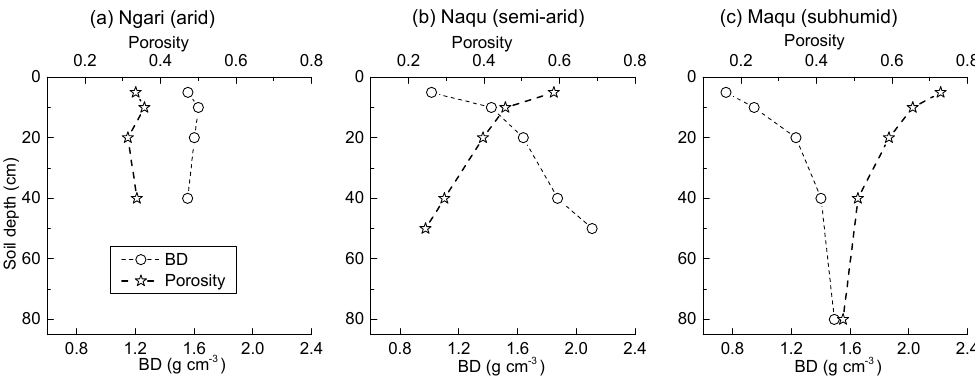
Figure 4. Profiles of mean dry bulk density (BD) and porosity at three climate zones.